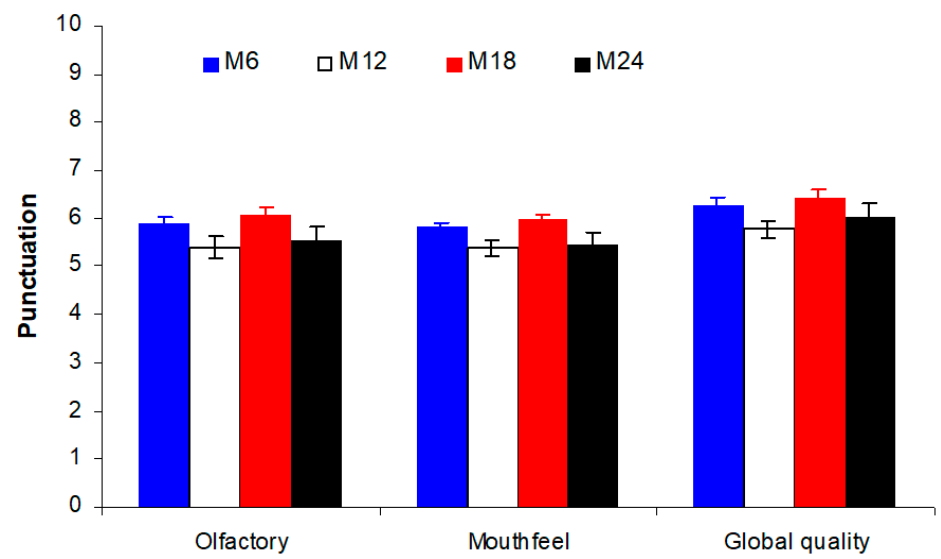
Figure 3. Punctuations for the olfactory and mouth phases of the sensory evaluation, as well as for the global quality of the Treixadura wines at different storage times in the bottle. Error bars represent standard errors. M6, M12, M18, and M24 indicate 6, 12, 18, and 24 months after bottling.